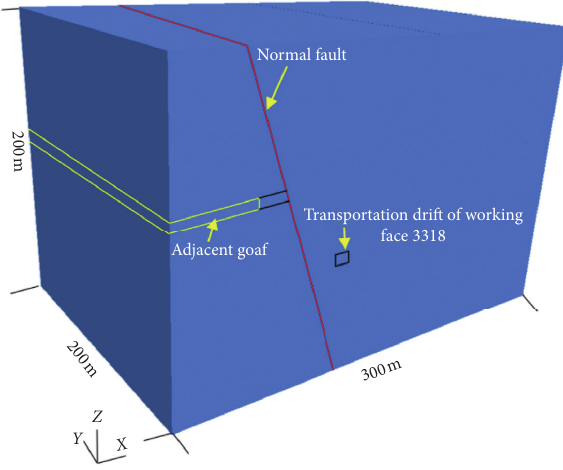
Figure 3: The numerical model for Table 1: Each layer of rock physical and mechanical parameters in model.